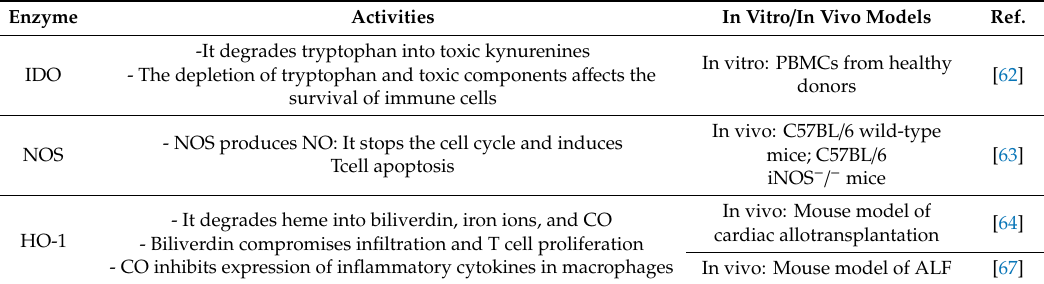
Table 2. Enzyme activities involved in MSC